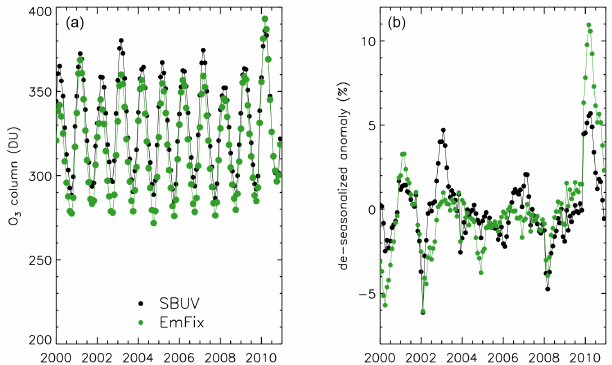
Figure 4. Monthly ozone column (a) and deseasonalized ozone col- umn anomaly (b) in SBUV data (black) and the EmFix simulation (green) for 30–60 ◦